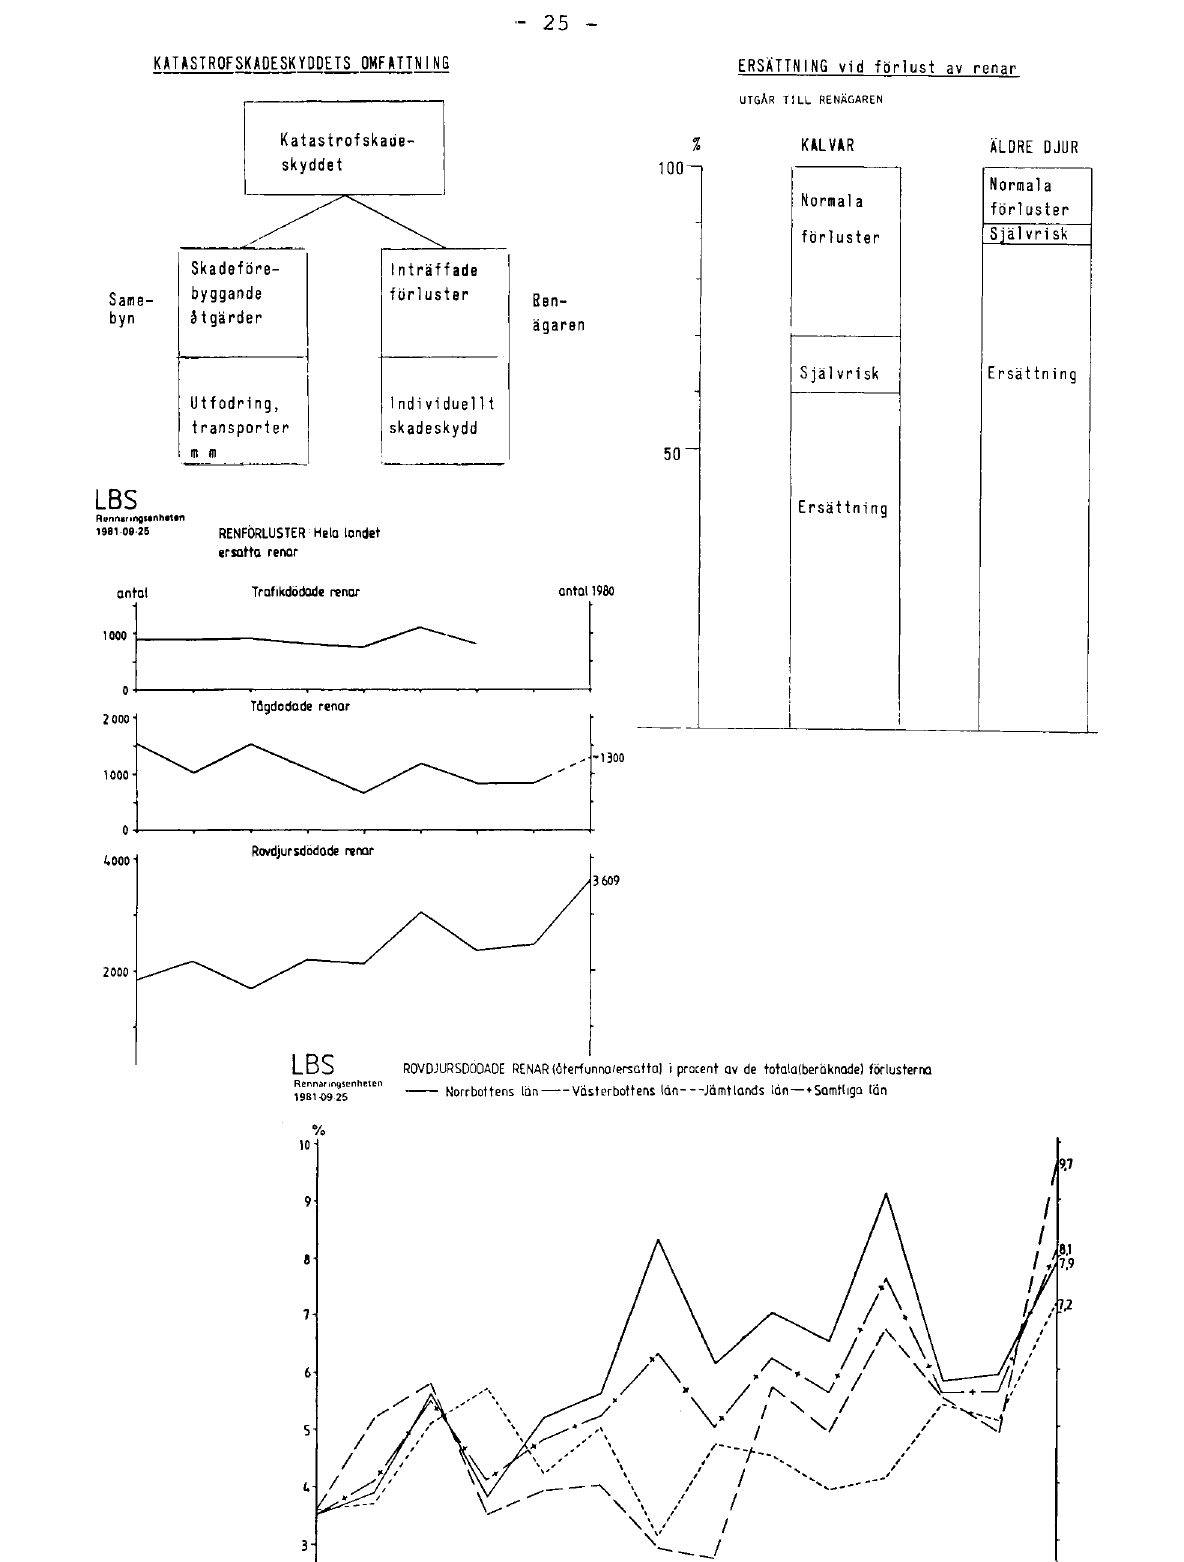
KATASTROFSKADESKYDDETS OMFATTNI NG